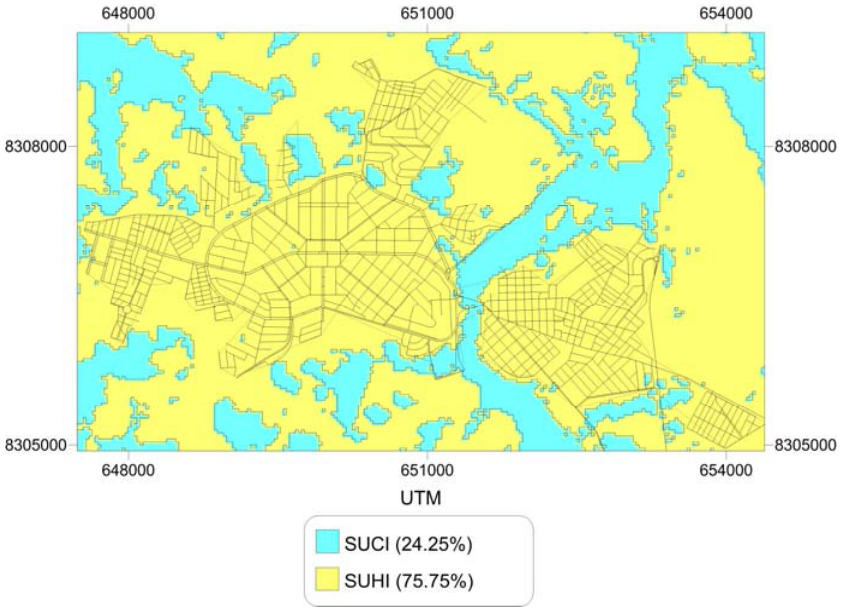
Figure 6. Average SUHIs of the cities of Ceres and Rialma, superimposed on the relief.